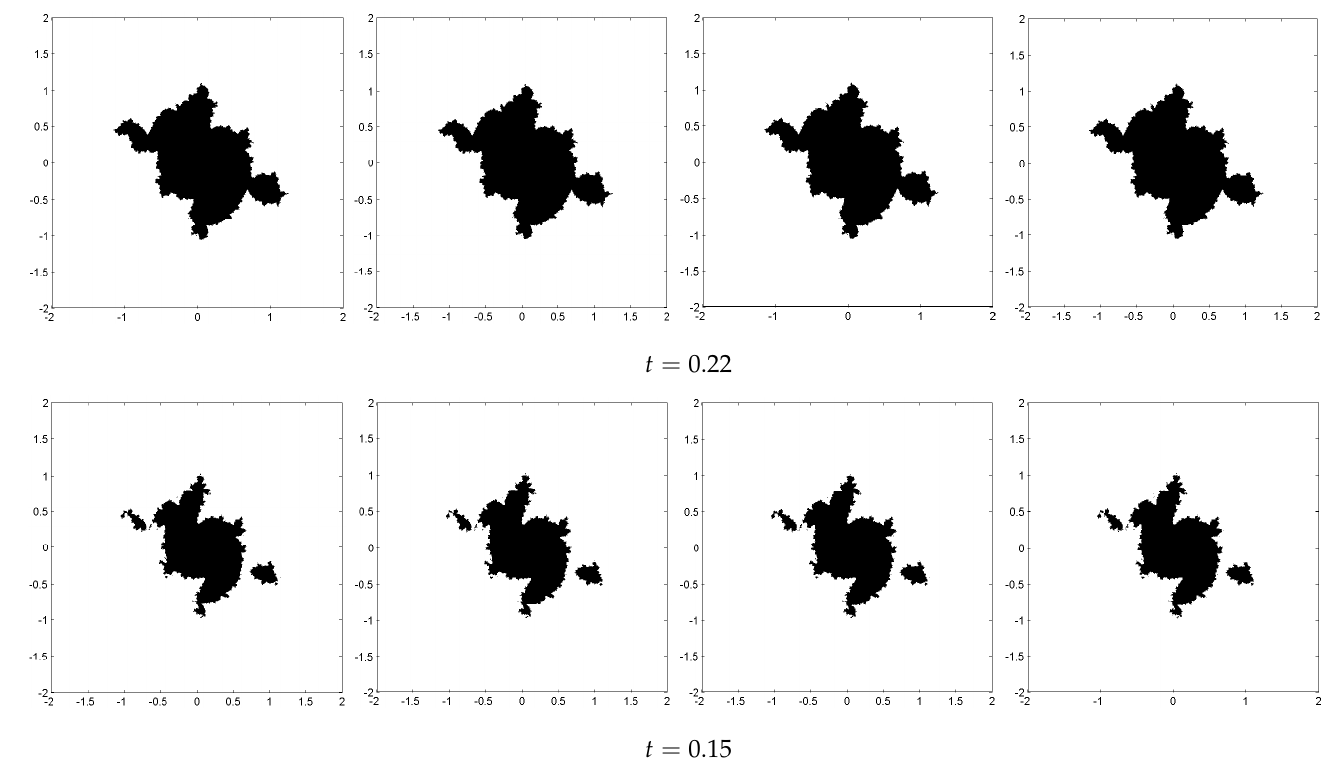
Figure 6. Consensus of Julia sets without leader and v = − 0.3 and different values of t in